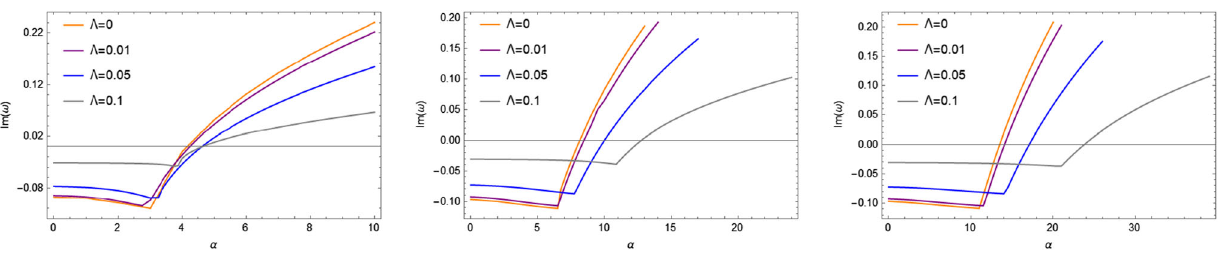
Fig. 3 The profile of the effective potential between the event horizon and cosmological horizon for (cid:4) = 0 , 1 , 2 from left to right